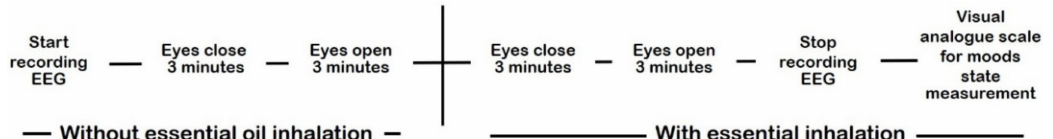
Figure 9. Experimental procedure divided into two trials. With tangerine essential oil inhalation and without tangerine essential oil